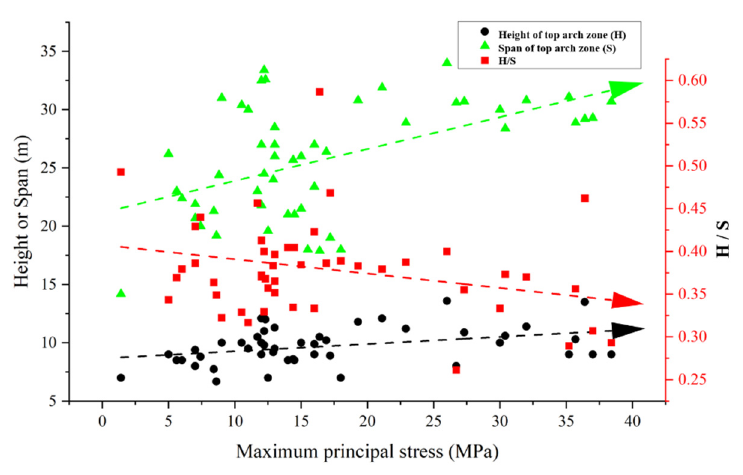
Figure 11. The relationship between height (H), span (S), H/S of the top arch zone and in situ stress level. stress level.